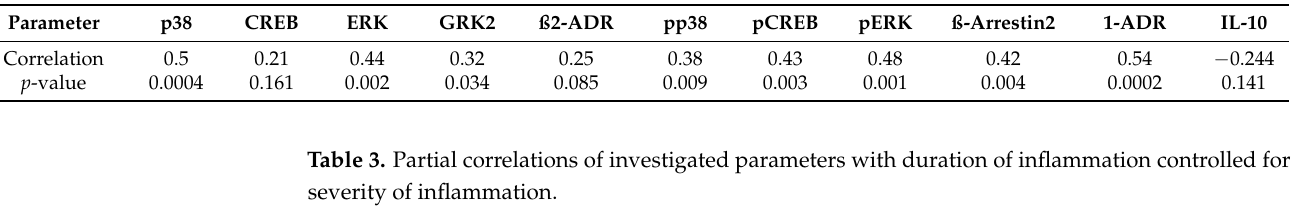
Table 2. Partial correlations of investigated parameters with severity of inflammation controlled for duration of inflammation.